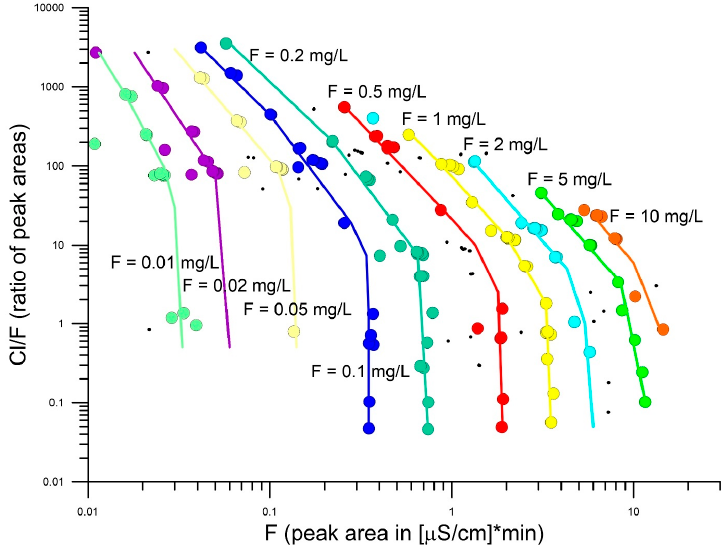
Figure 1. Relationship between F − peak area, Cl/F peak area ratio and the F − concentration of standard solutions with different Cl − concentrations. At high Cl − concentrations the F − peak area decreases significantly, suggesting apparently lower F − present in the sample than is actually present. Small black dots indicate intermediate, additional (not 1, 2, or 5) F concentrations used for calibrating the F concentrations.